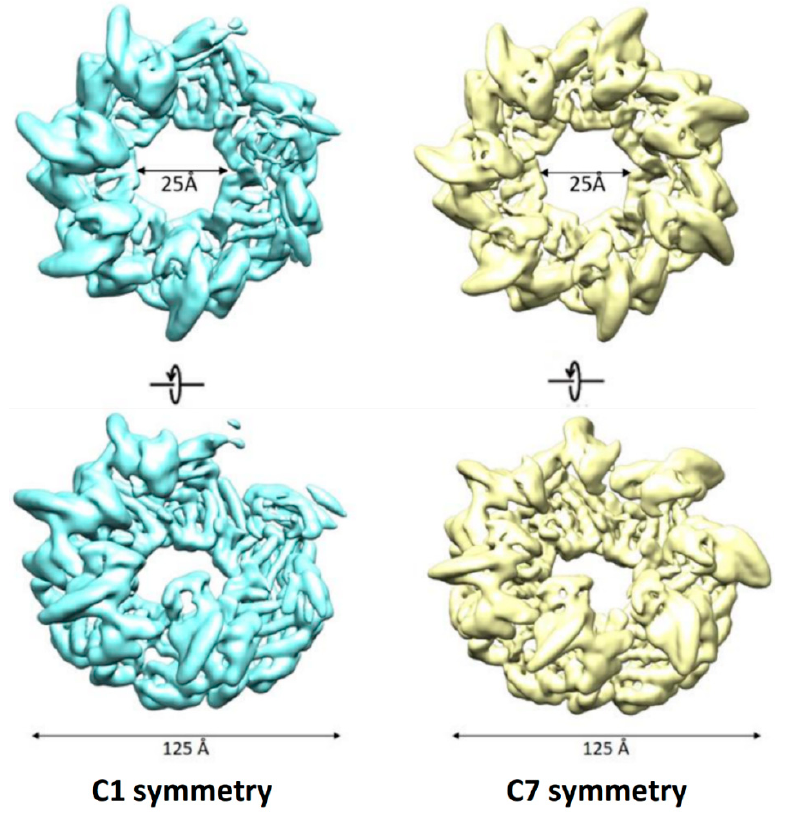
Figure 1. Cryo-EM density maps of AR9 chaperonin with no symmetry applied ( left ) and with C7 symmetry ( right ).